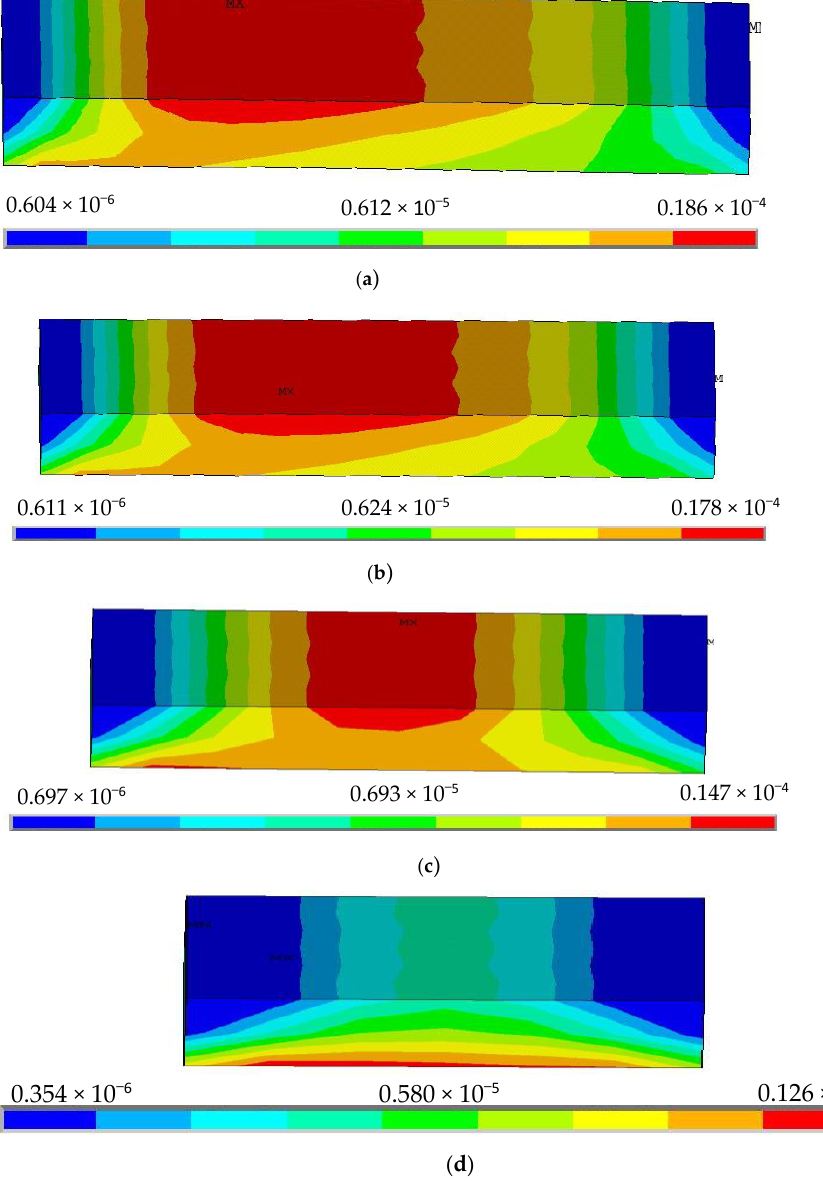
Figure 3. Stress distribution nephogram of silica gel with different lengths, ( a ) L = 30 mm, ( b ) L = 25 mm, ( c ) L = 15 mm, ( d ) L = 8 mm.